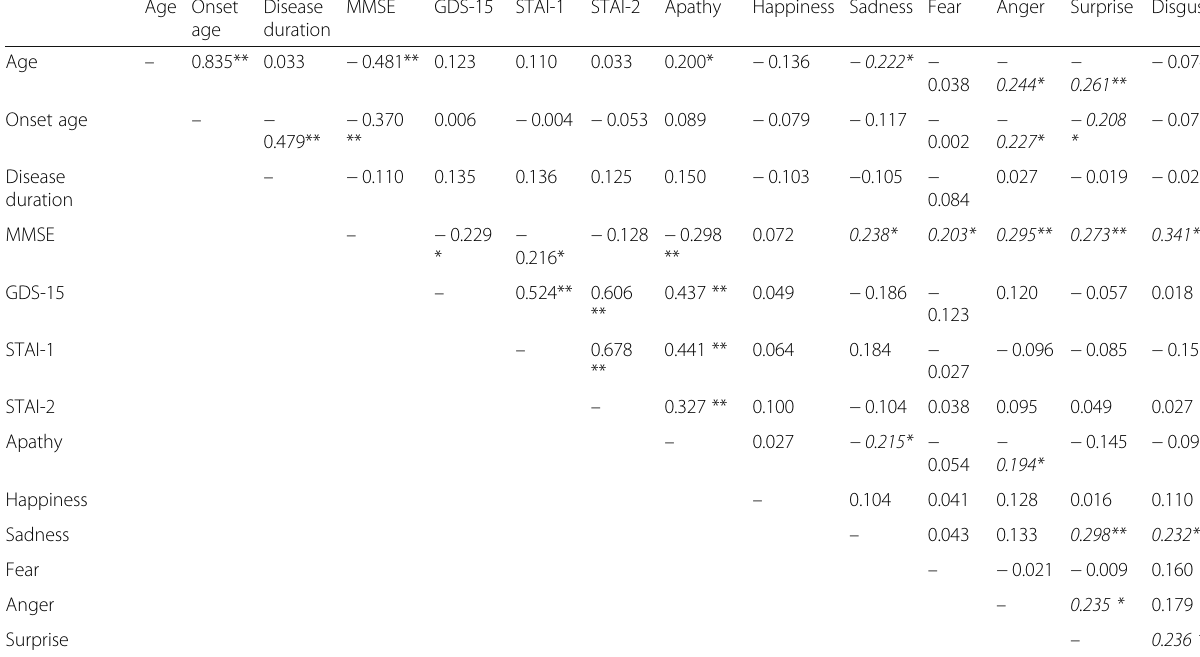
Table 4 Spearman ’ s rank correlation of facial expression recognition test accuracy rate and basic attribute items